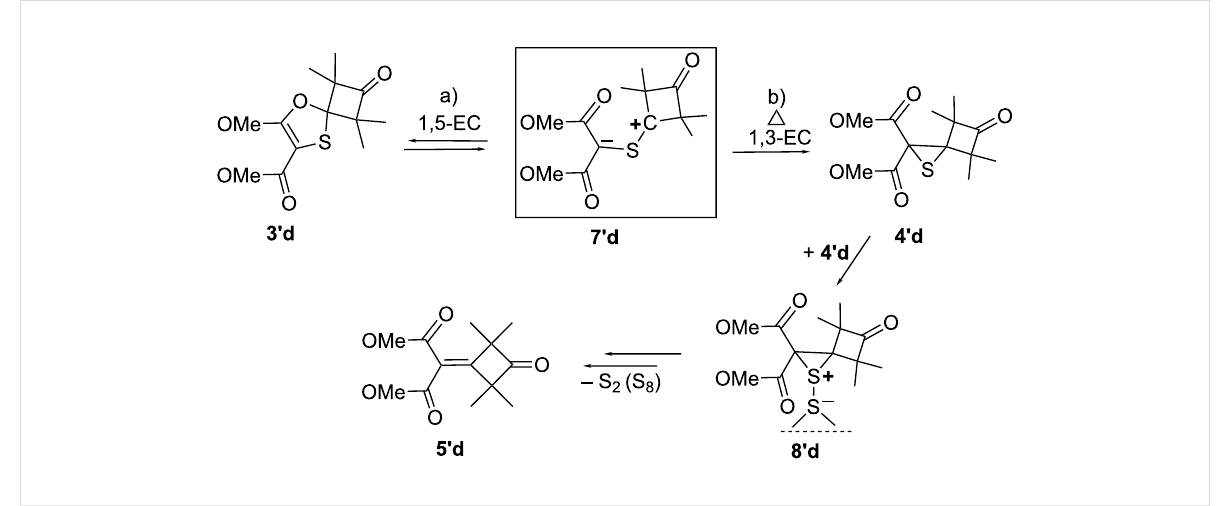
Scheme 3: Reactions of the intermediate thiocarbonyl ylide 7'd via competative 1,5-EC (a) or 1,3-EC (b) followed by desulfurization of thiirane 4'd into alkene 5'd